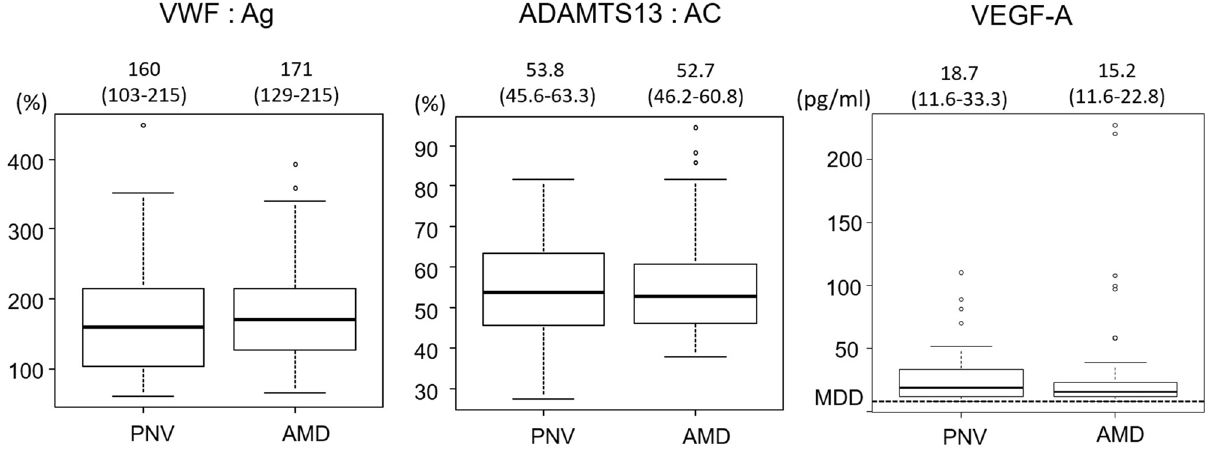
Figure 1. VWF: Ag, ADAMTS13:AC, and VEGF-A in PNV and AMD. Each of the values in the graph is the median with the interquartile range. VWF: Ag, plasma VWF: Antigen. ADAMTS13: AC, plasma ADAMTS13 activity. VEGF-A, vascular endothelial growth factor A. MOD, minimum detectable dose. the MDD of VEGF-A defined by the manufacturer was 9